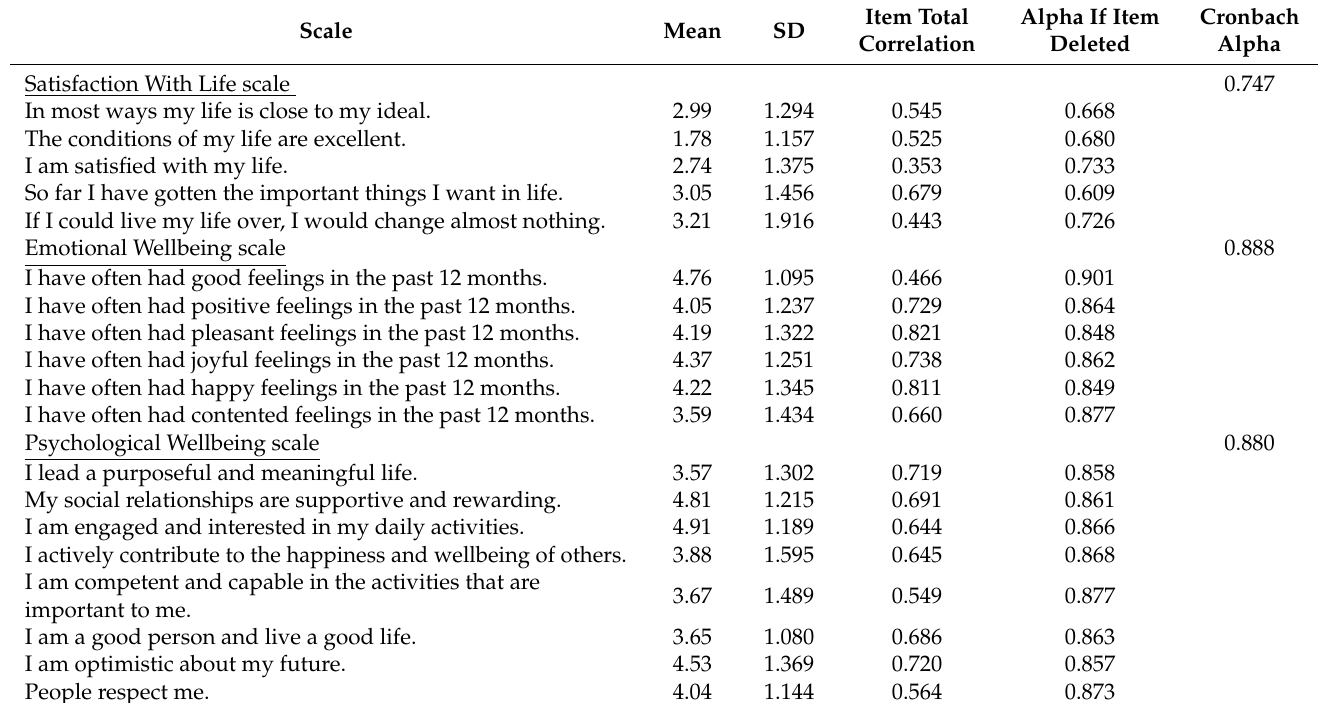
Table 2. Reliability of measures for wellbeing outcomes ( n =